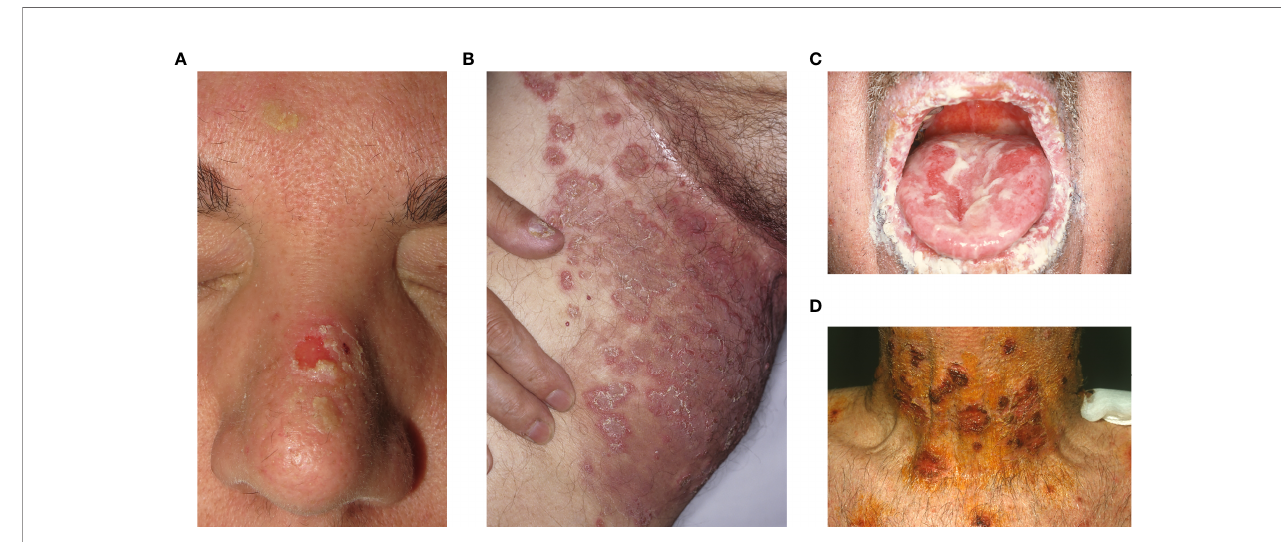
FIGURE 1 | Clinical features. (A) A 33-year-old woman with exclusively anti-Dsc1 IgG antibodies and pemphigus foliaceous clinical features with erosions and crusts in the seborrheic areas. (B) A 66-year-old man with exclusively anti-Dsc1 IgA antibodies and annular plaques with pustules in the groin diagnosed as IgA pemphigus SPD-type. (C, D) A 70-year-old man with both anti-desmocollin 2,3, and anti-desmoglein 1,3 antibodies and mucocutaneous pemphigus vulgaris clinical